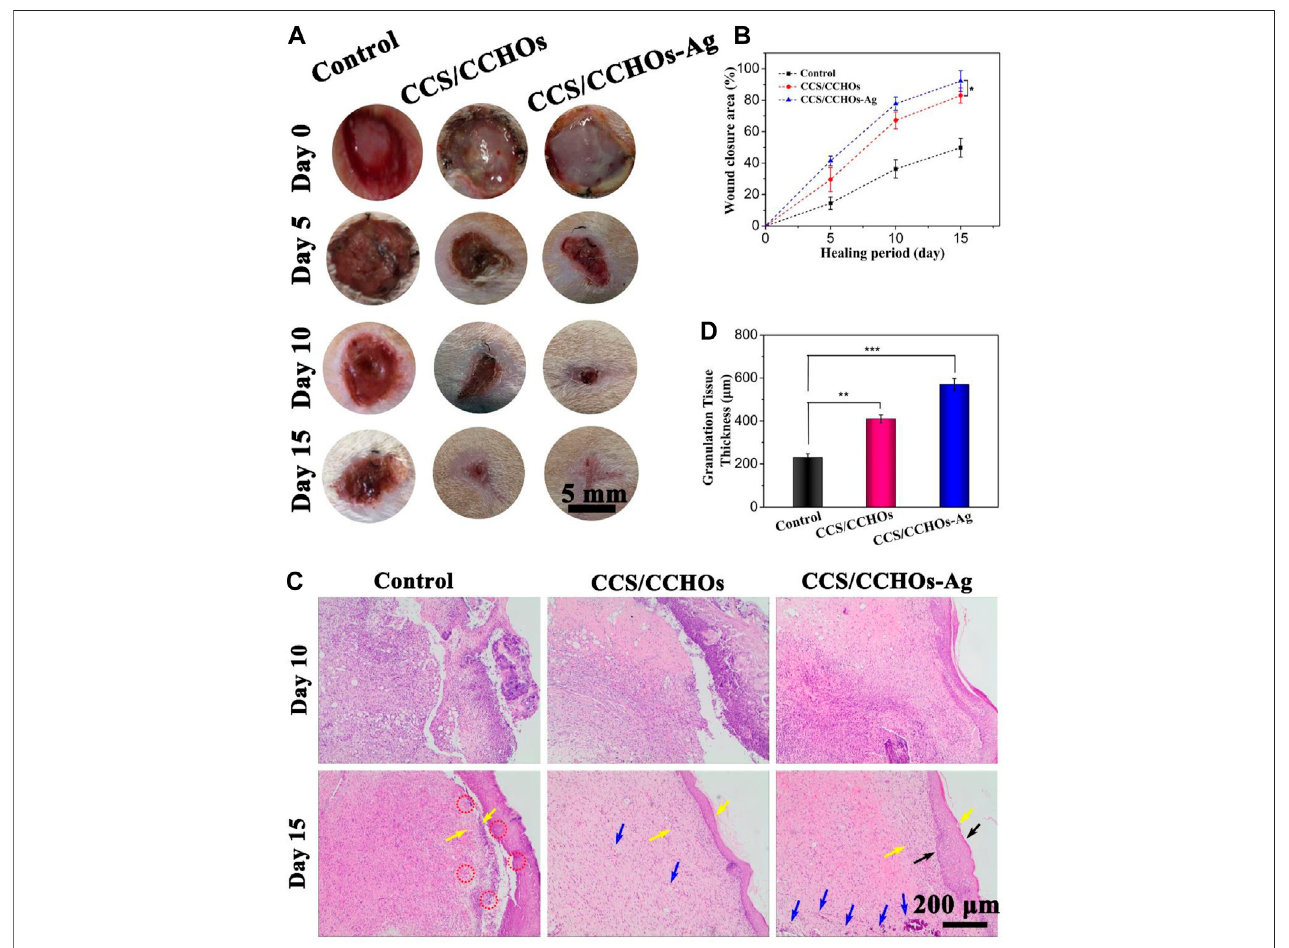
FIGURE5|(A) OpticalimagesofwoundsuntreatedortreatedwithCSS/CCHOandCCS/CCHO-Agdressingsondays0,5,10,and15. (B) Correspondinghealing rate of wounds. (C) Tissue slices stained with hemotoxylin and eosin (H&E) from different groups on days 10 and 15. (D) Quantitative analysis of the granulation tissue thicknesses (as pointed by the yellow arrows) using